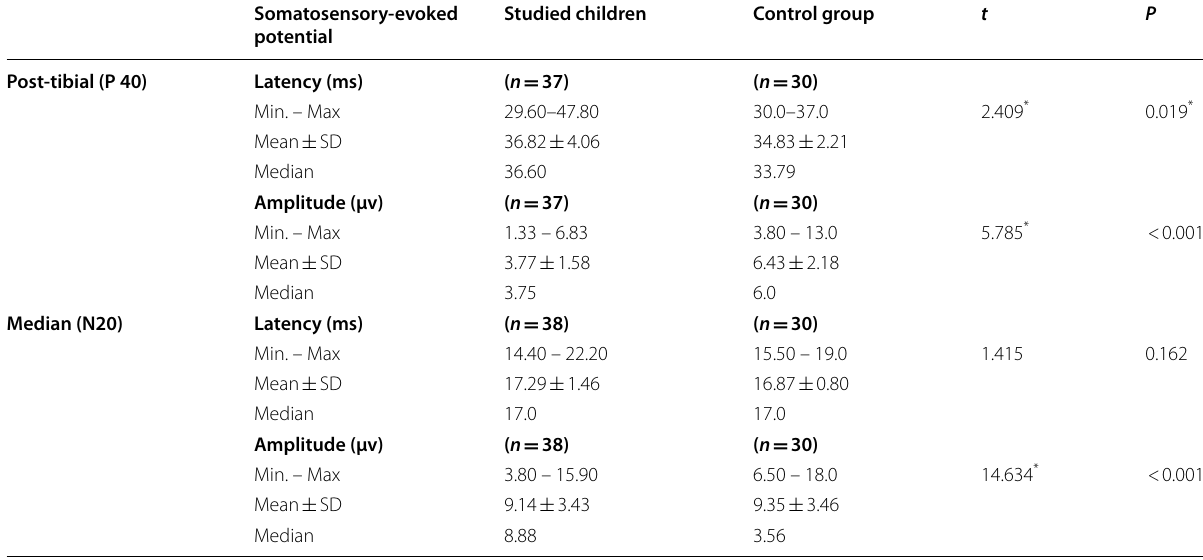
t Student’s t test. P P value for comparing between the two groups * Statistically significant at P ≤